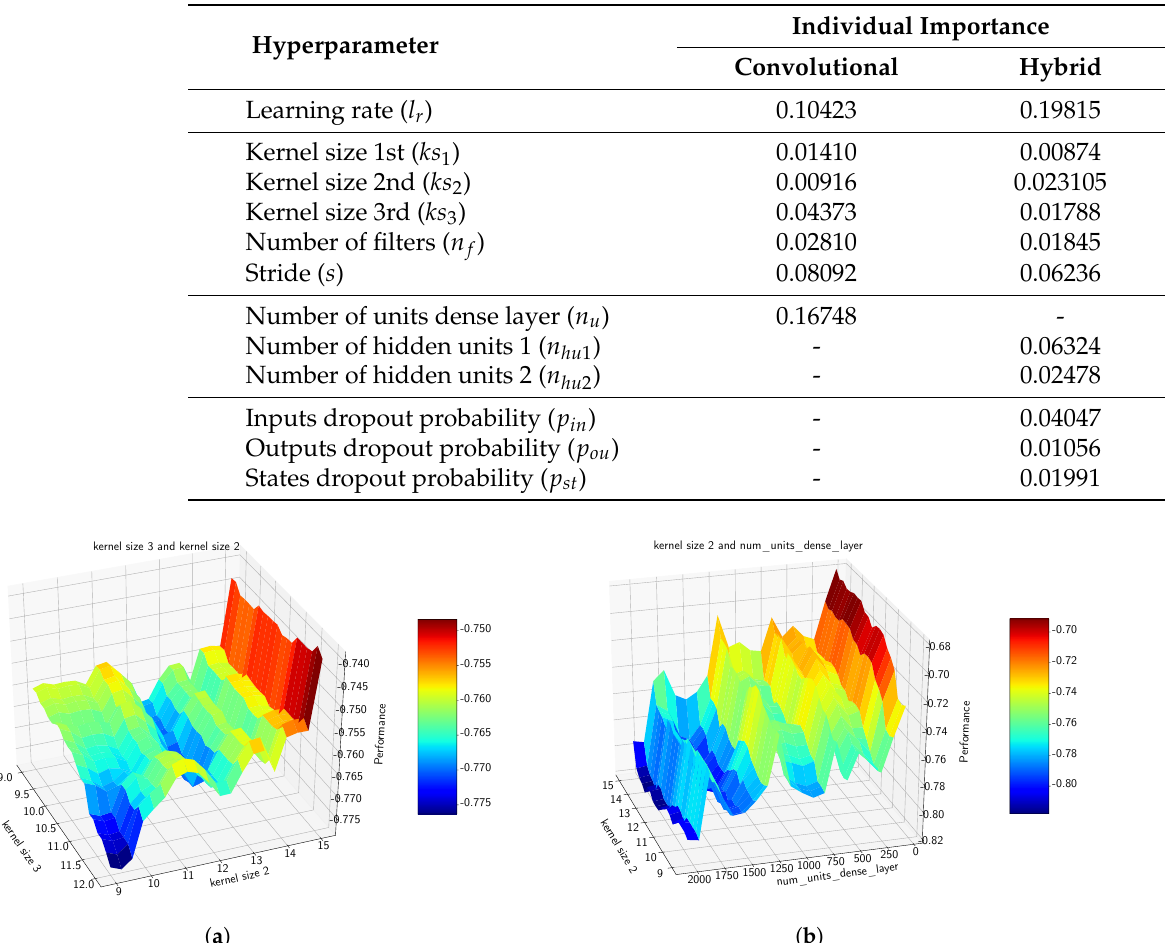
Table 2. Summary of the results obtained with the fANOVA analysis showing the importance of the individual importance of the hyperparameters associated with the architectures defined in Section 6.2.1. Architectures with recurrent output layers are referred to as Hybrid while those with dense output layers are referred to as Convolutional . From [109].